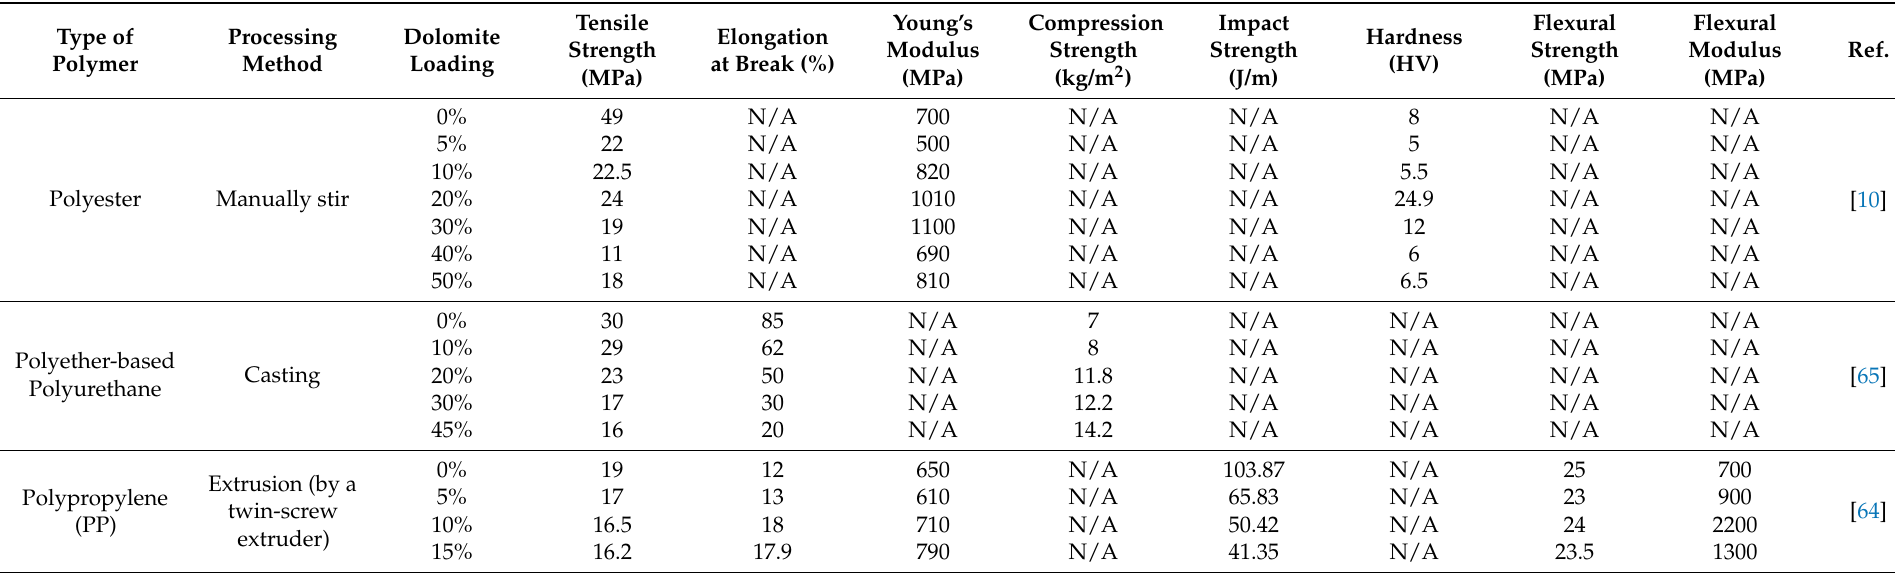
Table 3. Summary of literature studies reporting the type, processing method, and properties of polymer composites with dolomite